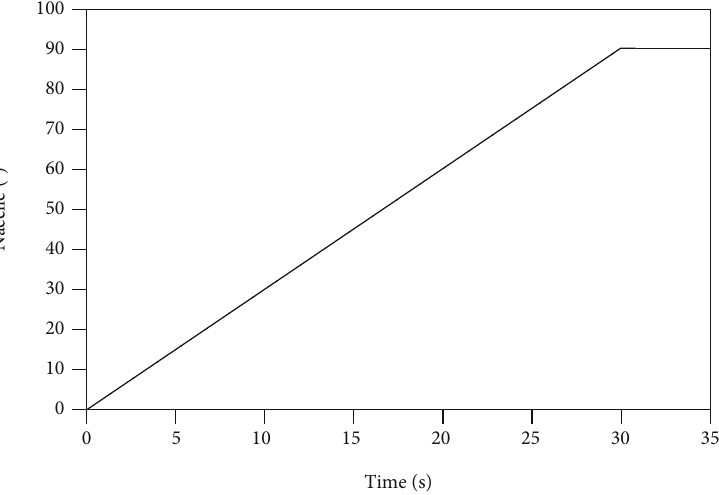
Figure 14: Nacelle angle change curve.